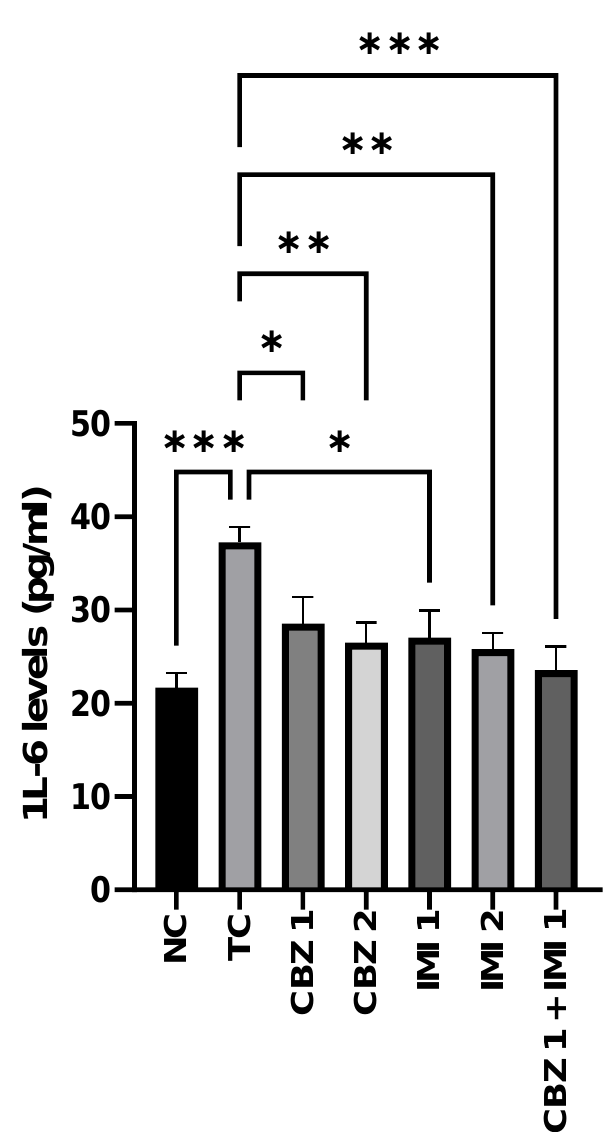
Figure 4. The effect of CBZ (20 and 50 mg/kg), IMI (10 and 20 mg/kg) and CBZ (20 mg/kg) + IMI (10 mg/kg) on hippocampal IL-6 levels. Statistical significance between means from toxic control and other groups was correlated by applying one-way ANOVA followed by post hoc Dunnet’s test. ( p < 0.05 *, p < 0.01 **, p < 0.001 *** significance levels). CBZ, IMI, and TC indicate carbamazepine, imipramine, and toxic control, respectively.